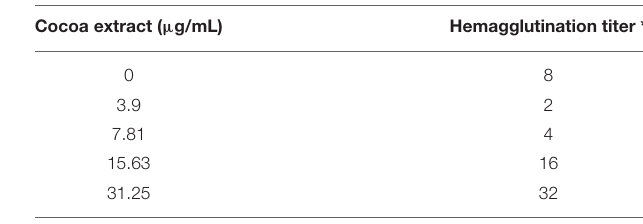
TABLE 1 | Effect of the cocoa extract on the hemagglutinating activity of P. gingivalis